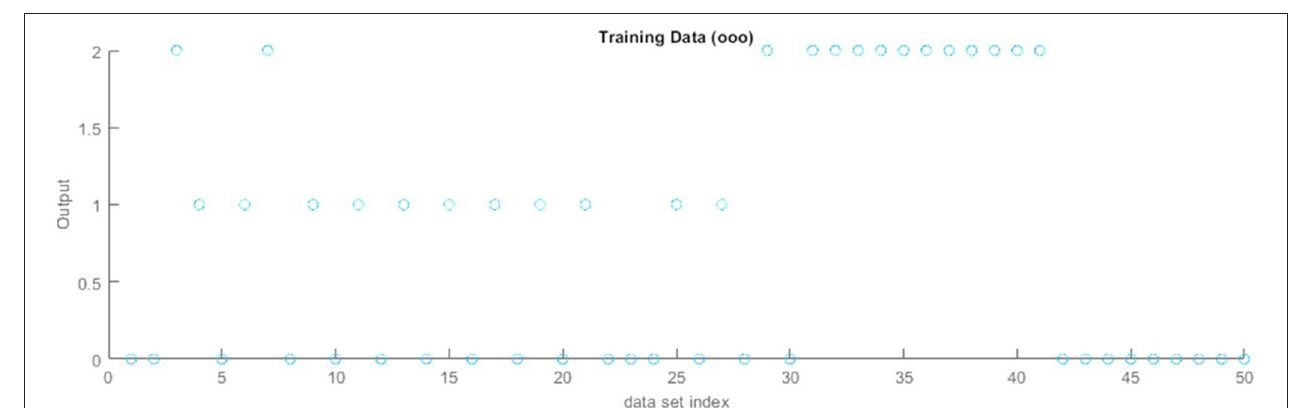
FIGURE 6 | (A–E) Set of rules based on membership functions.